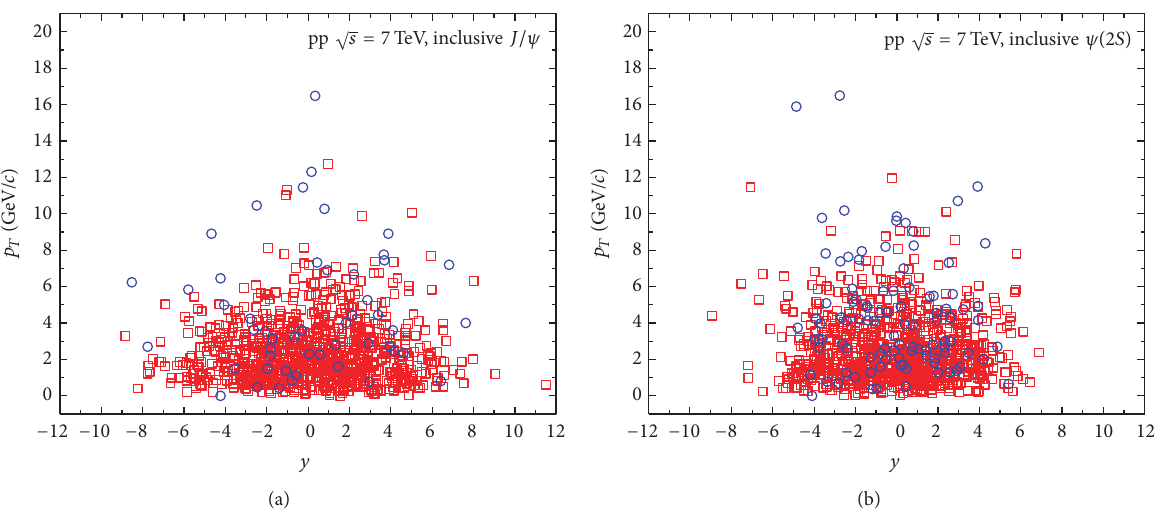
Figure 6: Same as Figure 3, but showing the results for (a) inclusive 𝐽/𝜓 mesons and (b) inclusive 𝜓(2𝑆) mesons produced in pp collisions at √𝑠 = 7 TeV.